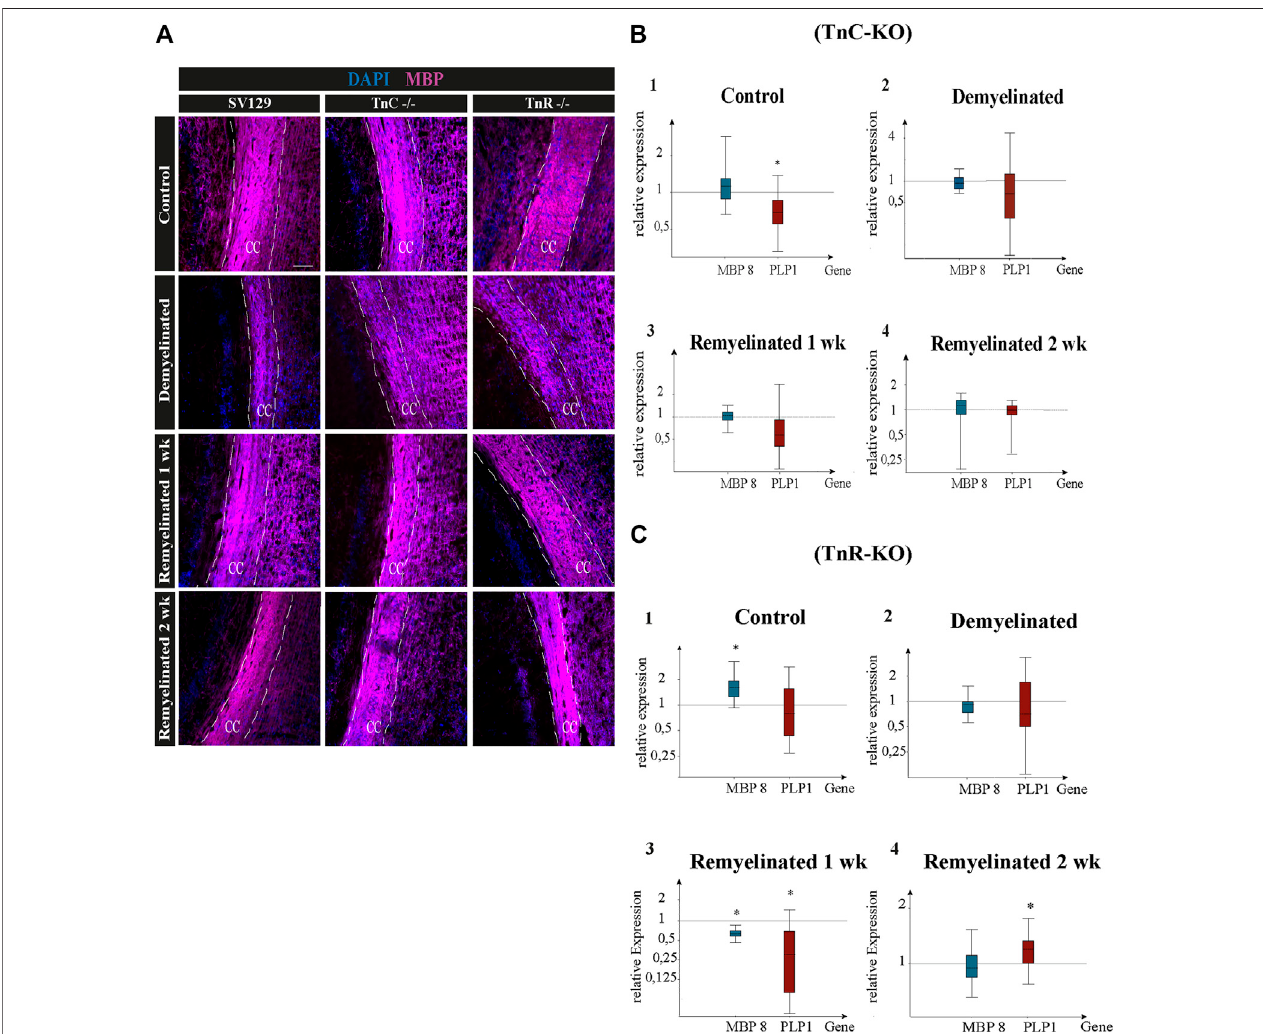
FIGURE6|(A – C) ImmunolabelingforMBPandgeneexpressionanalysisofthemyelingenesPLP1andMBP8inthecorpuscallosumofSV129, Tnc − / − ,and Tnr − /